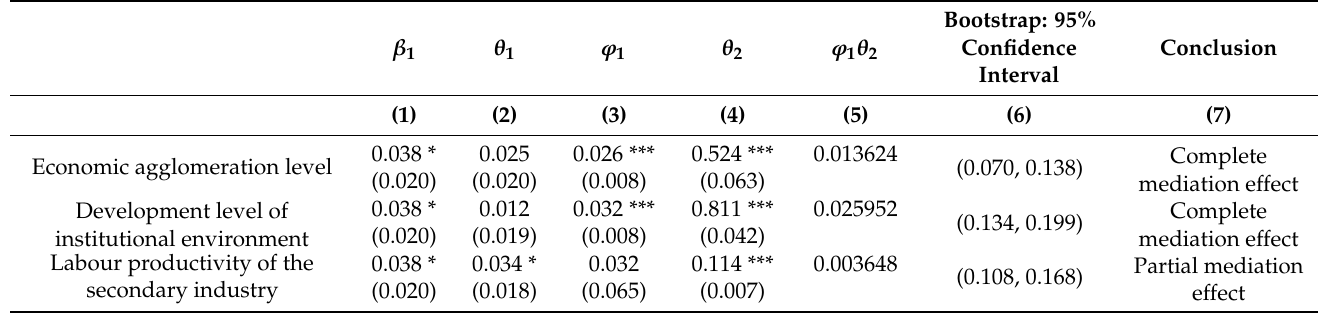
Table 5. Test results for the intermediary effect based on the agglomeration effect, institutional environment, and innovation